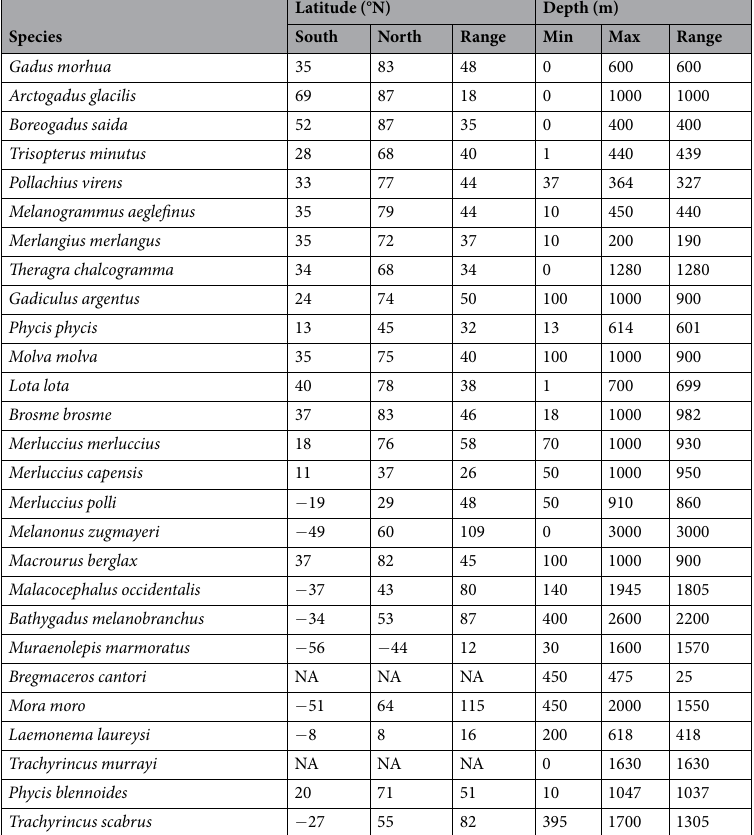
Table 1. The latitudinal distribution and depth of occurrence for the species of Gadiformes included in this study. Latitude is given in degrees north (°N) for the most southern and most northern observation for each species, respectively, as well as the range. Depth of occurrence is given in meters (m), with minimum and maximum depth recorded for each species, including